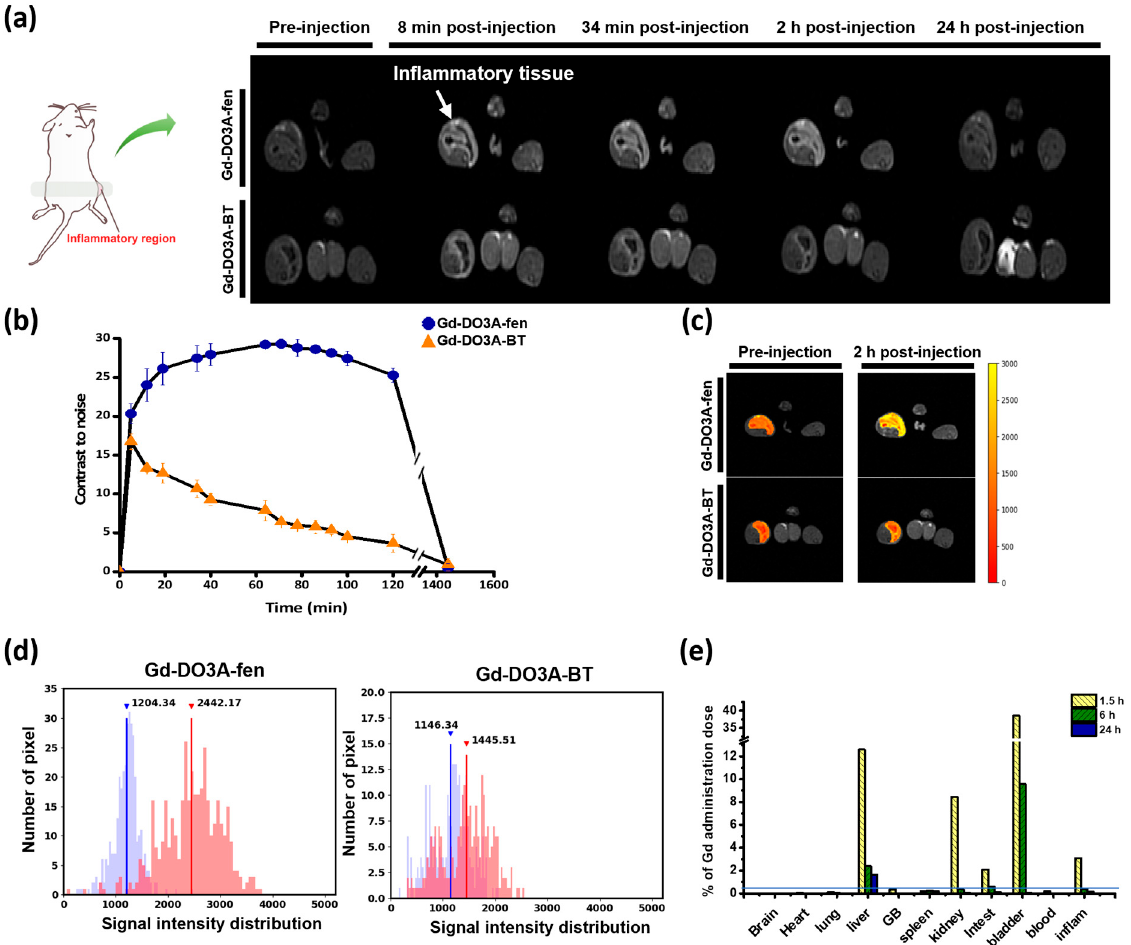
Figure 2. In vivo assessment in the inflammation-induced mouse model. ( a – c ) T 1 -weighted MR images were acquired before and after the administration of Gd-DO3A-fen and Gd-DO3A- BT (0.1 mmol/kg) by 1.5-T MRI. ( a ) Anatomical axial images of the inflammation site are dis- played in gray scale and ( b ) CNR profile is shown as a function of time. Values are expressed as mean ± S.D. ( n = 3). ( c ) Color-map at maximum-enhanced time. ( d ) Histogram of signal intensity values in the inflammatory region. The blue bars represent the signal intensity distribution for preinjection data, and the red bars represent the data obtained at 2 h postinjection of Gd-DO3A-fen (left) and Gd-DO3A-BT (right). Each line and value on the graph represent the average values for each distribution. ( e ) The inflammation-induced mouse model was sacrificed after the administra- tion of Gd-DO3A-fen to quantify the in vivo biodistribution at each time point ( n = 4). The results show the amount of Gd (mmol) in each tissue as a percentage (%) of total Gd administration dose (0.1 mmol/kg). The amount of Gd (mmol) in different tissues was determined by ICP-AES. GB, gallbladder; intest, intestines; inflam, inflamed